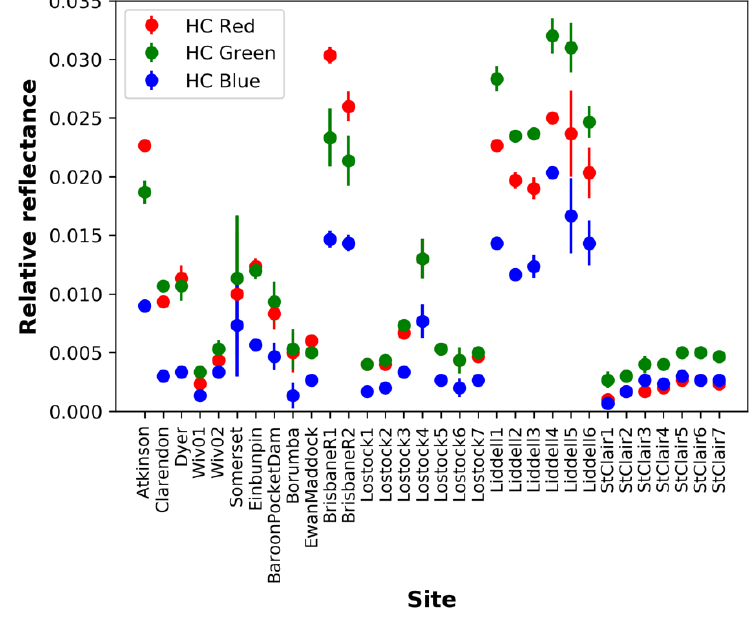
Figure 12. Summary of HC-derived Rrs (RGB) for all measurements, with variation between the three replicate HC RGB values expressed as bars indicating standard error.